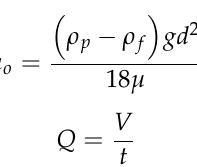
Figure 3. Disk-stack centrifuge used at the Minamisoma pilot plant.